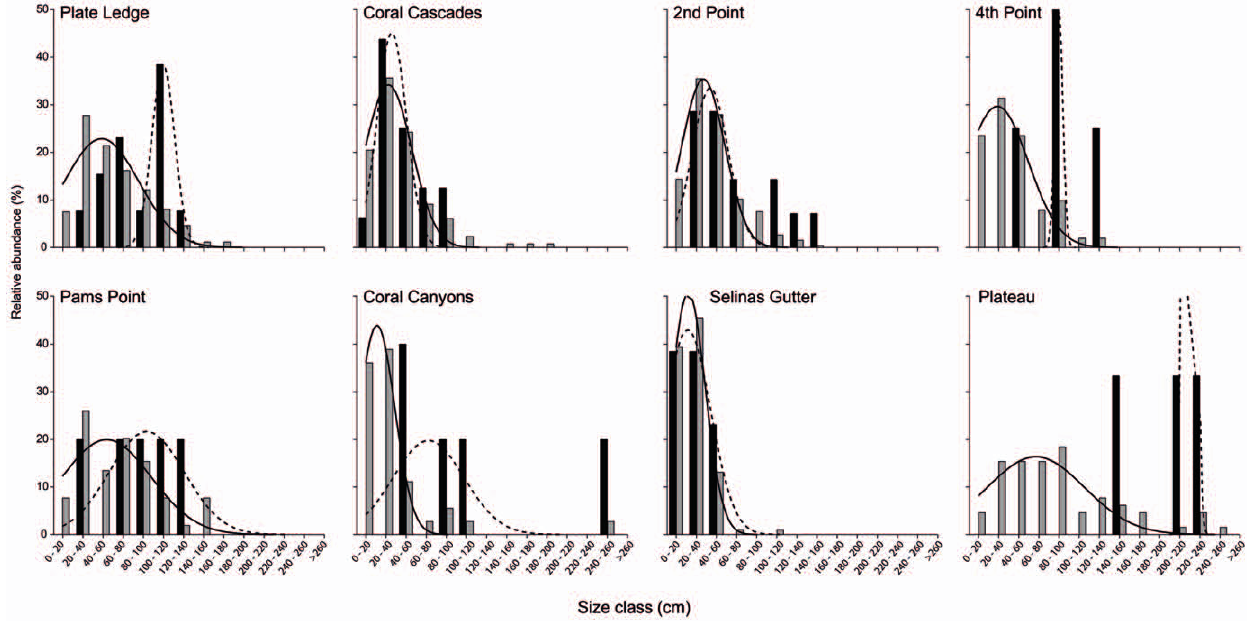
Figure 4. Size frequency distributions of healthy and white syndrome affected tabular Acropora spp. Grey columns=healthy colonies, black columns=white syndrome affected colonies. Histograms fitted with normal distributions (solid line=healthy colonies, dashed line=white